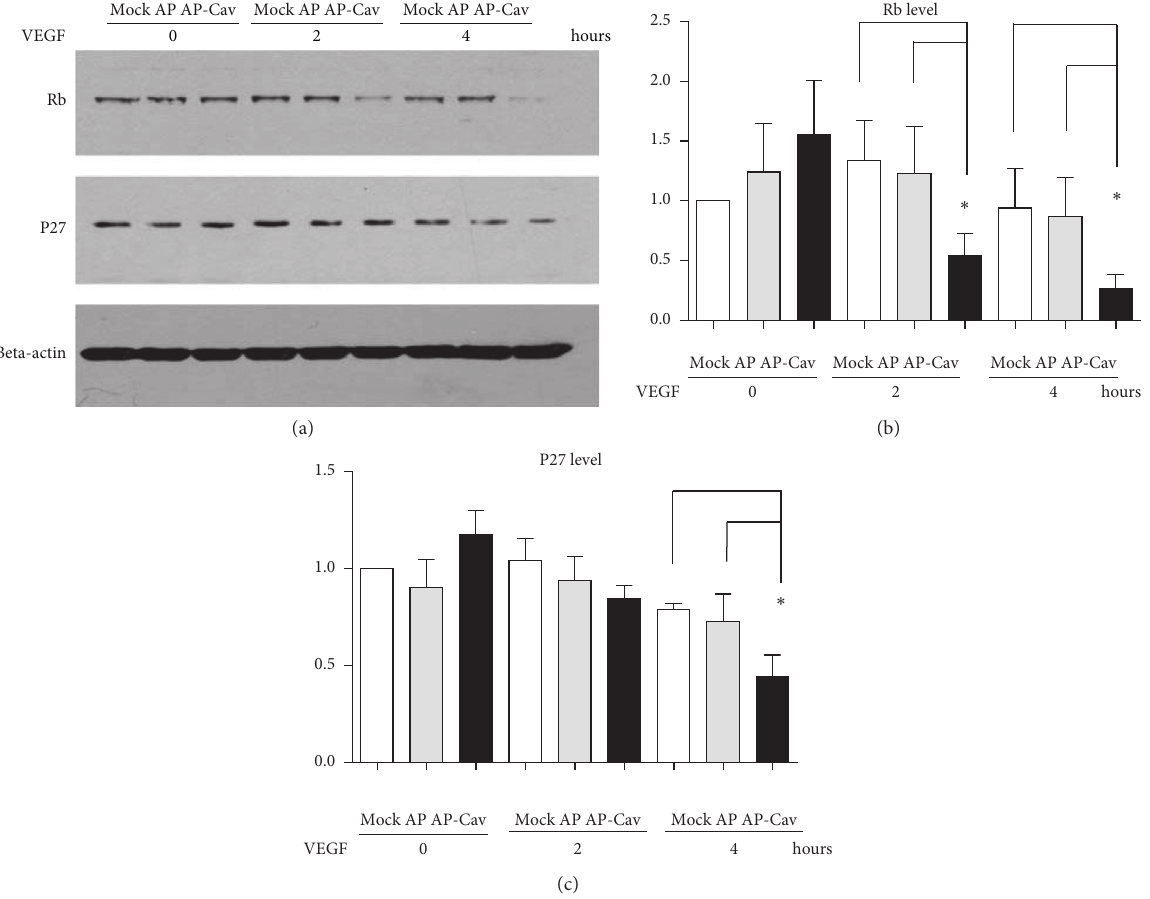
Figure 3: Effect of AP-Cav on cell cycle protein level of p27 kip1 , Rb in mouse colon endothelial cells. (a) After overnight low serum starvation, 30 minute AP-Cav peptide treatment, and stimulation with 50ng VEGF/ml for 0, 2, and 4 hours, cells were subjected to SDS- PAGE and western blot analysis with specific antibodies for p27 kip1 or Rb. Beta-actin was used as a loading control. (b) Bar graph represents relative Rb level normalized to beta-actin level. (c) Bar graph represents relative level of p27 kip1 normalized to beta-actin level. Data are mean ± s.e.m. from three independent experiments, ∗ p < 0 .